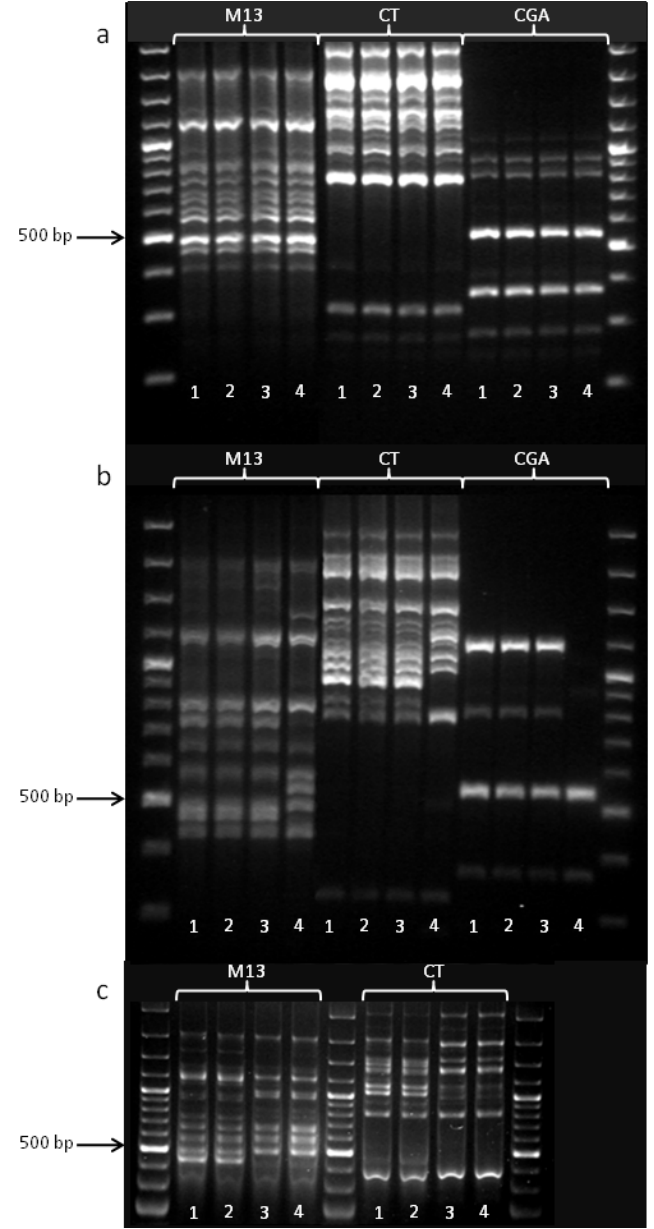
Figure 1. Examples of M13 and RAMS patterns of Inonotus rickii isolates. a) Lane 1 - C.5.1; Lane 2 - C.5.2; Lane 3 - C.5.3; Lane 4 - C.2.1. b) Lane 1 - B.1.1; Lane 2 - B.2.1; Lane 3 - B.3.1; Lane 4 - B.4.1. c) Lane 1 - G.1.1; Lane 2 - G.2.1; Lane 3 - H.1.1; Lane 4 -